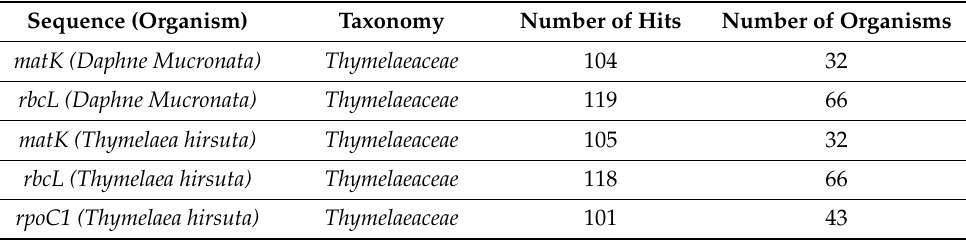
Table 3. NCBI taxonomy Entrez results; running obtained sequences via blastn and retrieving the lineage hits and number of aligned sequences related to Thymelaeaceae